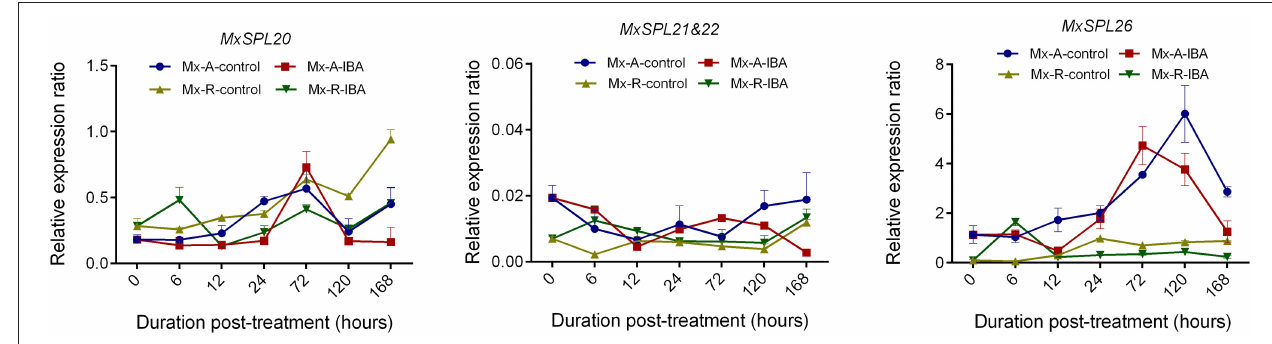
FIGURE 11 | Expression profile of MxSPL20, 21 & 22, and 26 genes during adventitious root formation in Malus xiaojinensis leafy cuttings. RNA was extracted from Mx-A and Mx-R stem bark after IBA treatment at serial time-points. Relative expression was measured using quantitative real time PCR normalized to MxEF1 α . Bars show SD from three biological replicates.